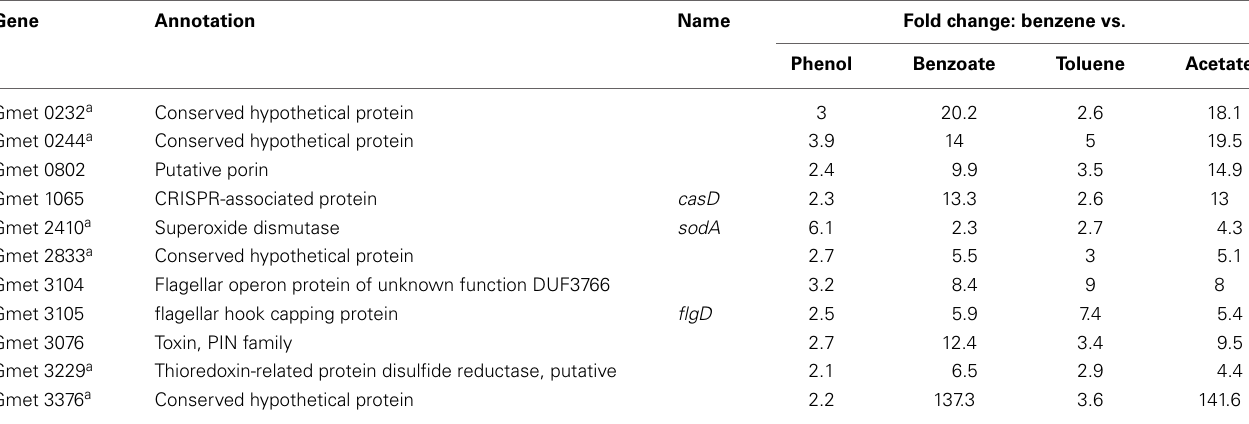
Table 1 | Genes up-regulated at least two fold in G. metallireducens when benzene is the electron donor ( P- value cutoff ≤ 0.1; NCBI GEO under accession number